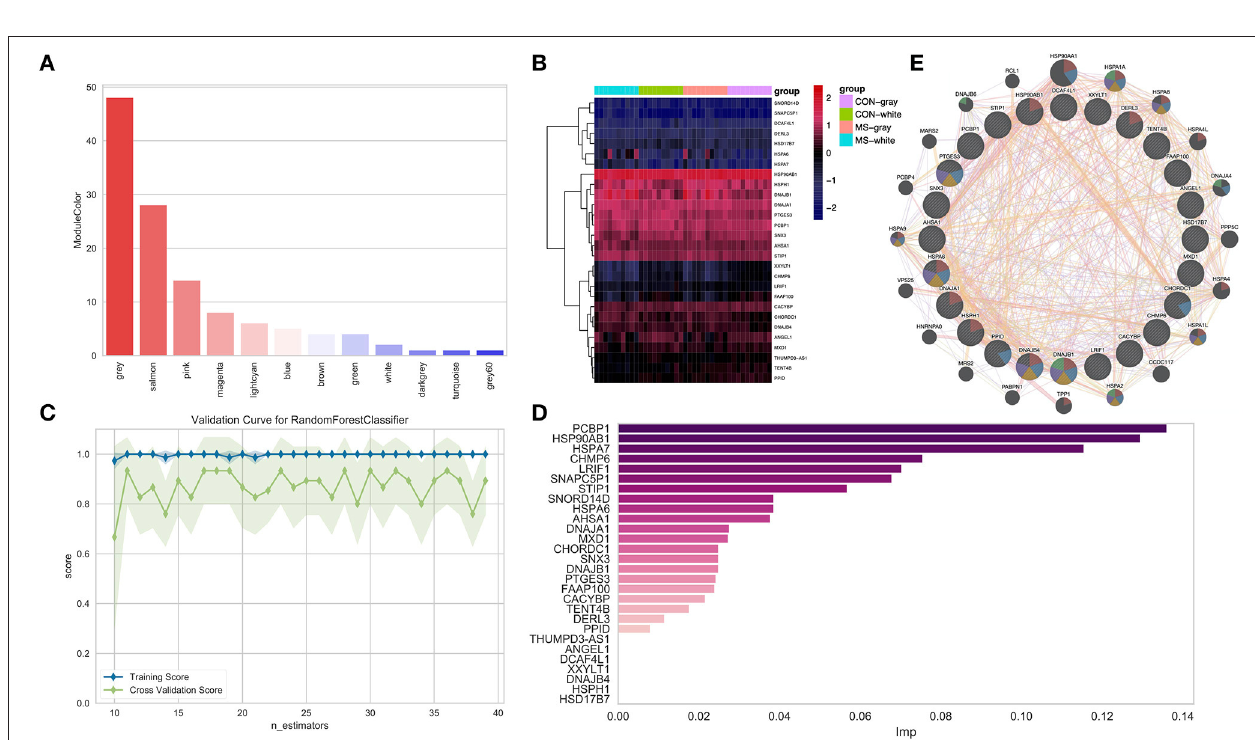
FIGURE 4 | corresponds to an eigengene tagged by consensus module colors. Within each heatmap, red represents high adjacency (positive correlation) and blue represents low adjacency (negative correlation) as represented by the color legend. (D) Bar plot shows the preservation degree of each consensus eigengene as the height of the bar ( y -axis), and each colored bar corresponds to the eigengene of the associated consensus module. The high-density value D (preserve WM and GM) = 0.79 indicates the high overall preservation between the WM and GM networks. (E) Adjacency heatmap of the preservation network between WM and GM consensus eigengene networks. The saturation of the red color indicates correlation preservation of WM and GM MEs.